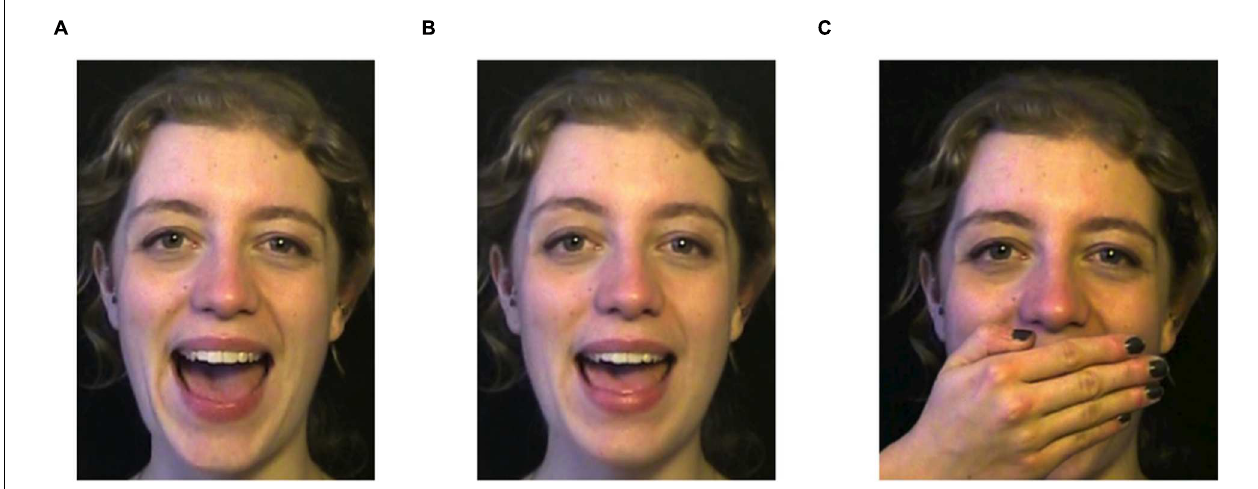
FIGURE 1 | Stills from the training videos. (A) and (B) are taken from video 1 and video 32 in the multimodal and visual conditions. (C) is taken from video 11 from the auditory condition, in which infants saw no visual articulation information.